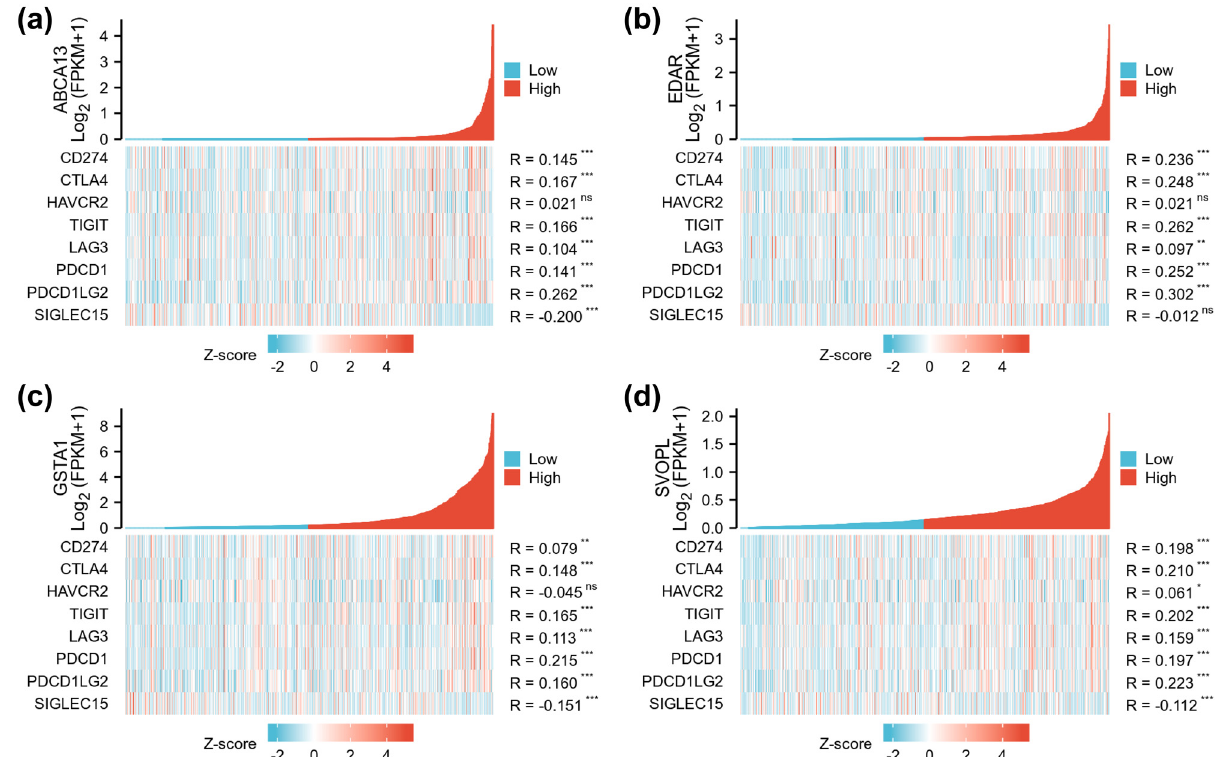
Figure 8: The involvement of ABCA13, EDAR, GSTA1, and SVOPL genes in tumor immunity of breast cancer. The co - expression heatmap presented the correlation between ( a ) ABCA13, ( b ) EDAR, ( c ) GSTA1, and ( d ) SVOPL expression and eight typical immune checkpoint genes. * p < 0.05, ** p < 0.01, and *** p <